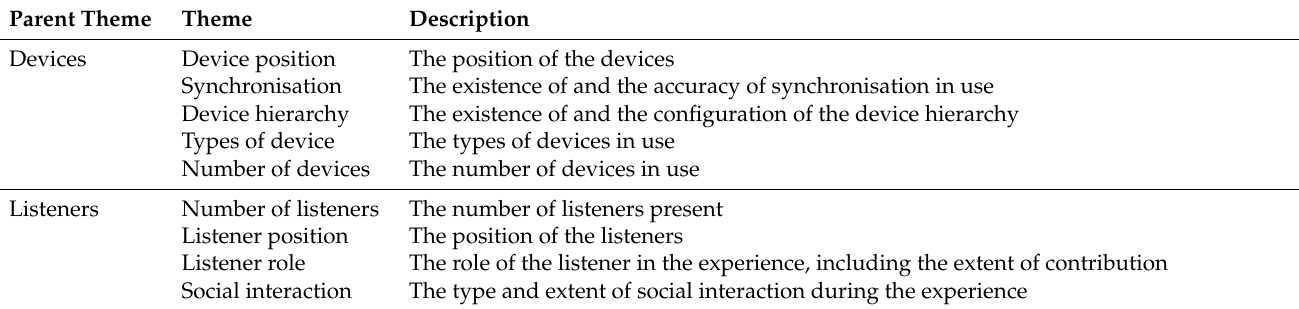
Figure 1. Pie charts representing the frequency of types of devices and modes of interaction for the multiple choice response data. ( a ) The frequency of types of devices for all survey responses. ( b ) The frequency of modes of interaction for all survey responses. Table 1. The 17 themes generated from the thematic analysis of the free-text survey responses, their descriptions, and associated parent